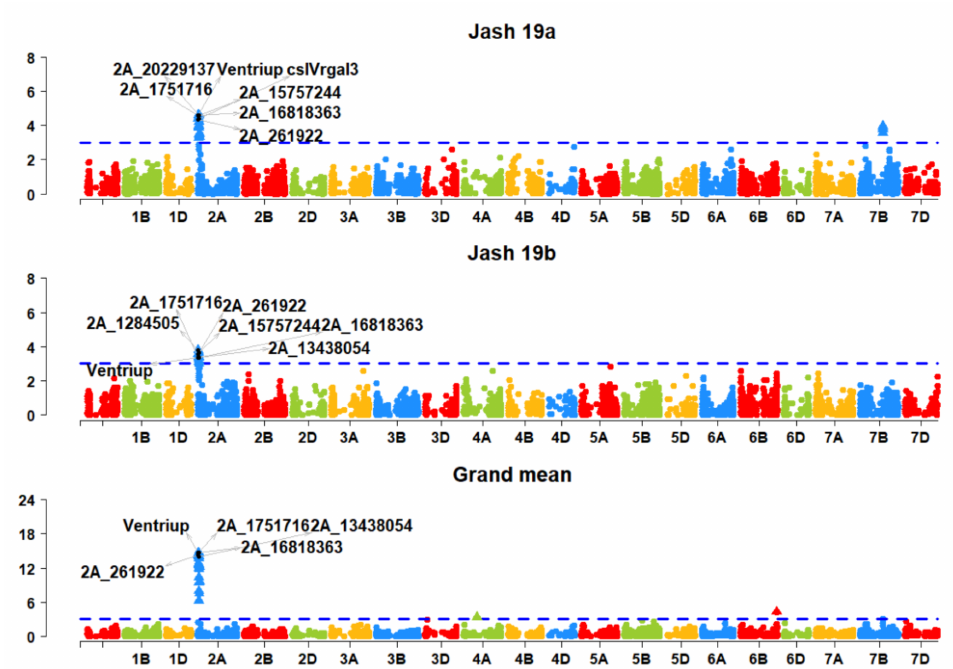
Figure 2. Manhattan plots showing markers significantly associated with WB in all the environments and grand mean. Key markers in each environment are visualized. A Bonferroni α level of 0.20 was used to determine the significant markers.